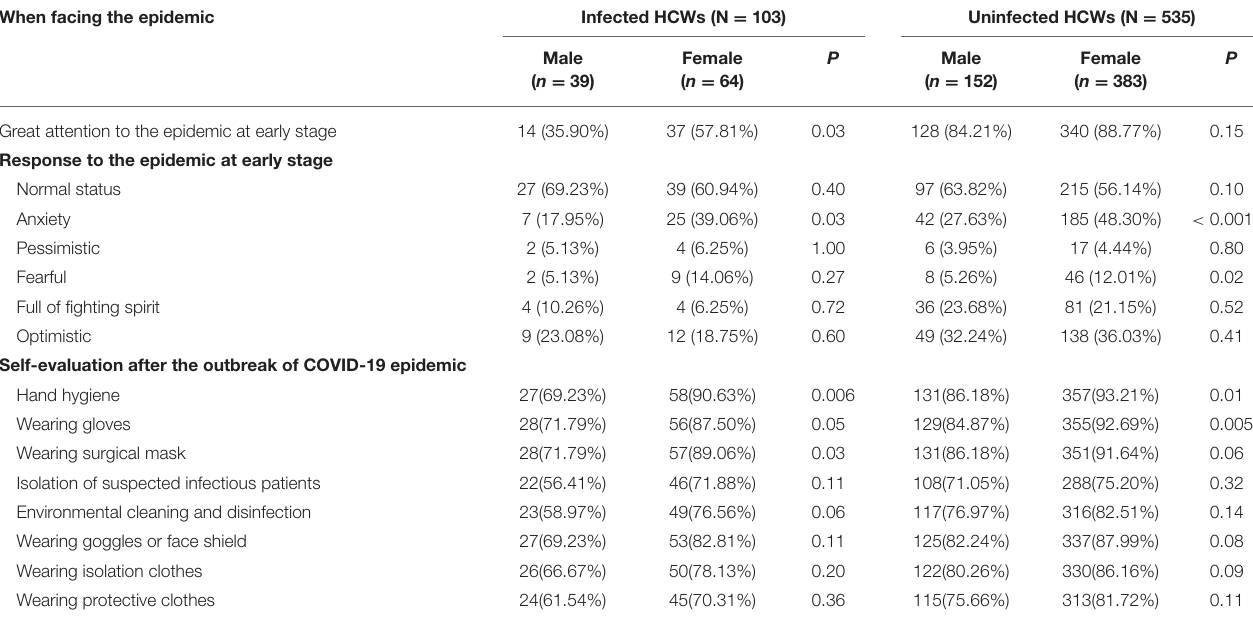
TABLE 2 | Group comparison between male group and female group on facing conscious and self-evaluation on protective measures to COVID-19. When facing the epidemic Infected HCWs (N =